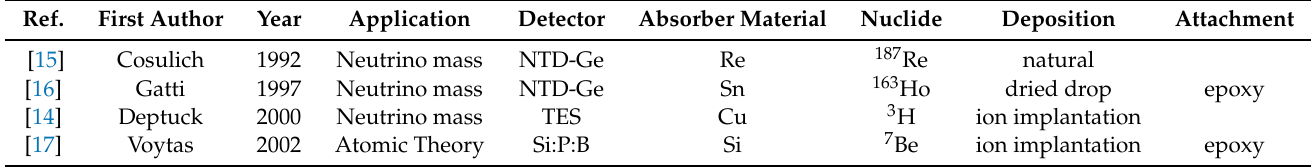
Table 1. Meta data for four papers. These data were derived from information within the paper where possible. Ref.